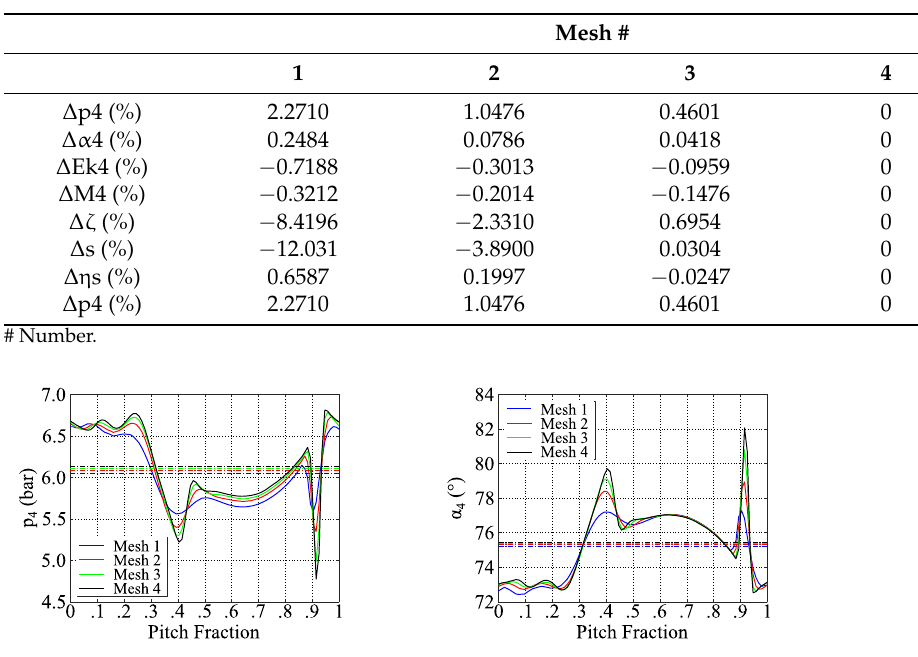
Figure 5. Influence of mesh size on mid-span pitch-wise distributions at rotor inlet radius (solid line) and average value (dash-dot line): static pressure; absolute flow angle.